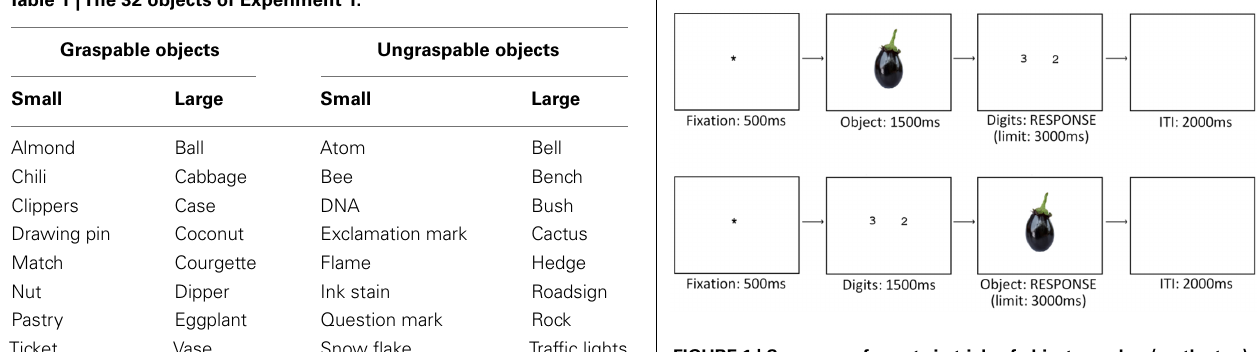
FIGURE 1 | Sequence of events in trials of object–number (on the top) and number–object (on the bottom) conditions. At the beginning of each trial, a fixation cross appeared on the center of the screen.The fixation cross was replaced by the first target (for example, an object in the object–number condition) and then by the second target (for example, a pair of digits in the object–number condition) until the vocal response execution or until 3000ms had elapsed. After a delay of 2000ms, the next trial began. Note that stimuli are not drawn to